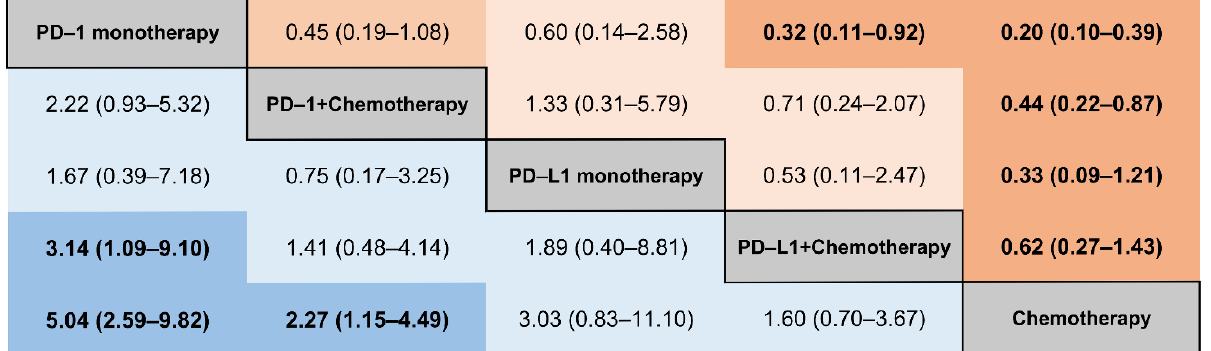
Figure 5. Different ICI comparisons for all grades of IRP based on network consistency model. Comparisons should be read from left to right. RRs for comparisons are in the cell in common between the column ‐ defining and row ‐ defining treatment, and bold numbers with darker backgrounds are statistically significant; values that were borderline significant are in a lighter shade. An RR > 1 means the treatment in the top left is worse. The numbers in parentheses represent 95% confidence intervals.